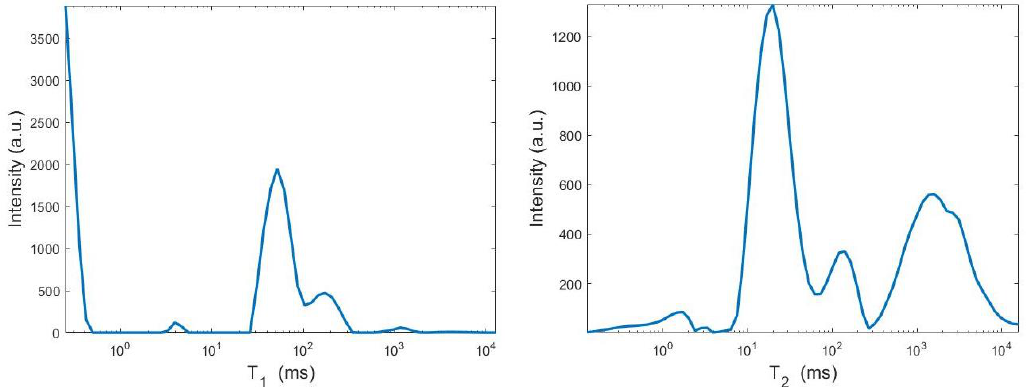
Figure 14. From top to bottom : UPEN, Hybrid and VSH projections along the T1 ( left ) and T2 ( right )